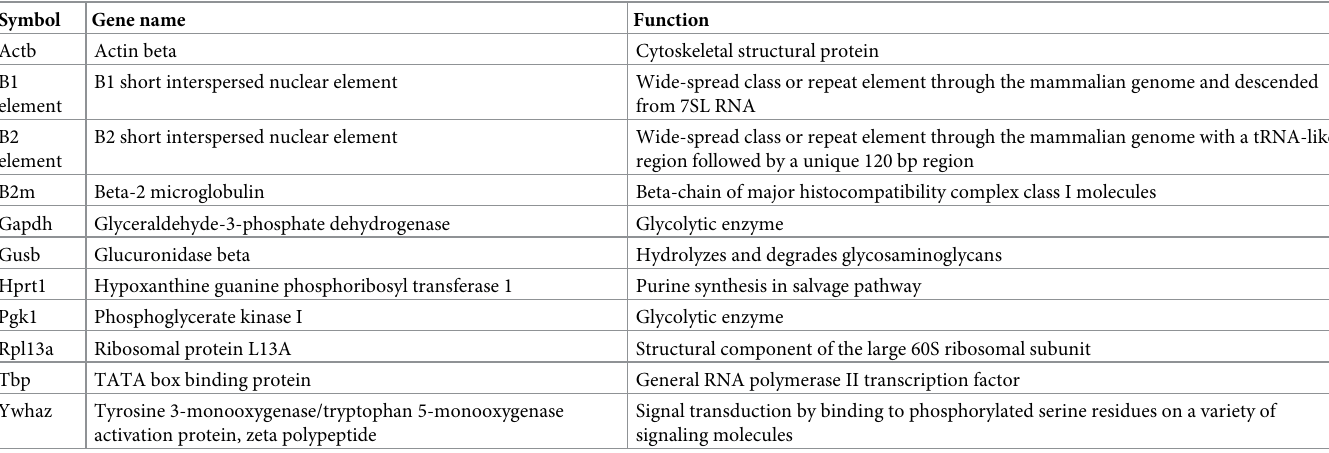
Table 1. Name and function of genes and short interspersed nuclear elements.